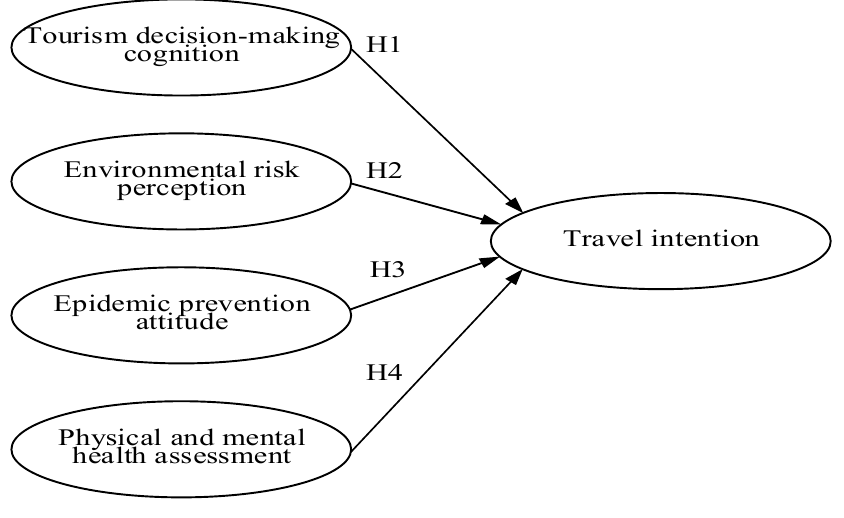
Figure 1. The research structure.